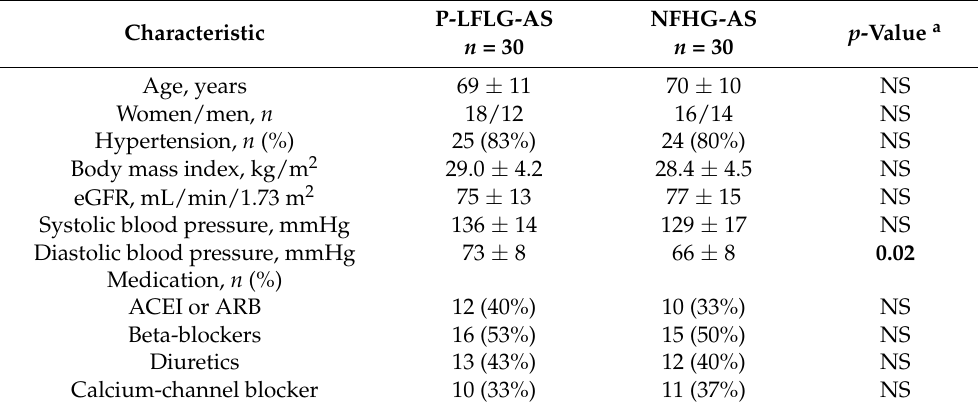
Table 1. Clinical characteristics of patients with P-LFLG-AS vs. NFHG-AS.